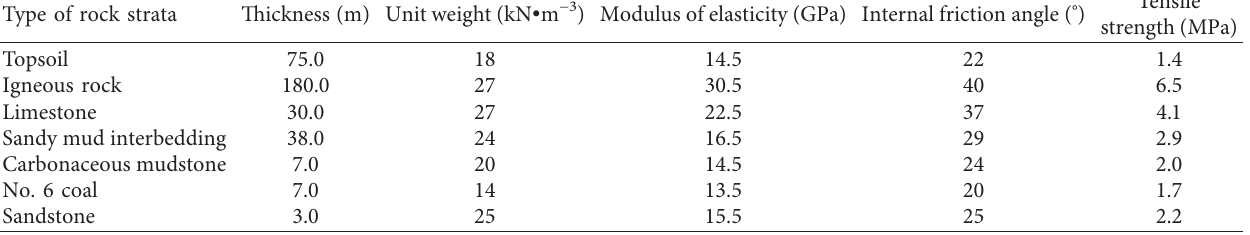
Table 1: Mechanical parameters of the rock model.